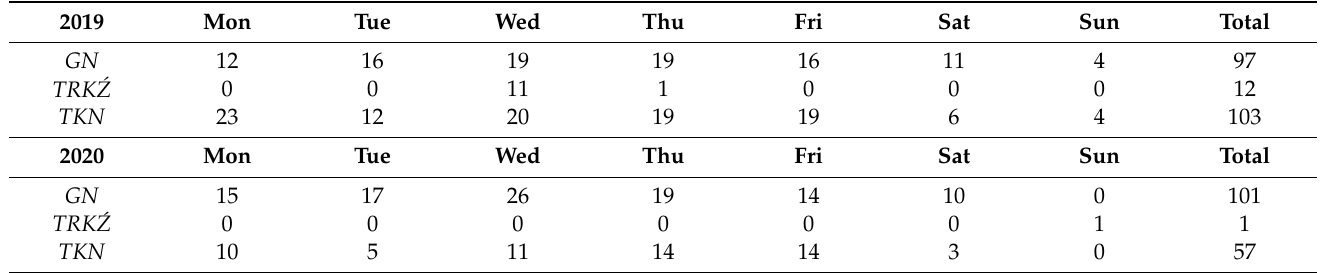
Table 7. The number of posts on the YouTube profiles of the selected Catholic weeklies by day of the week (2019–2020).